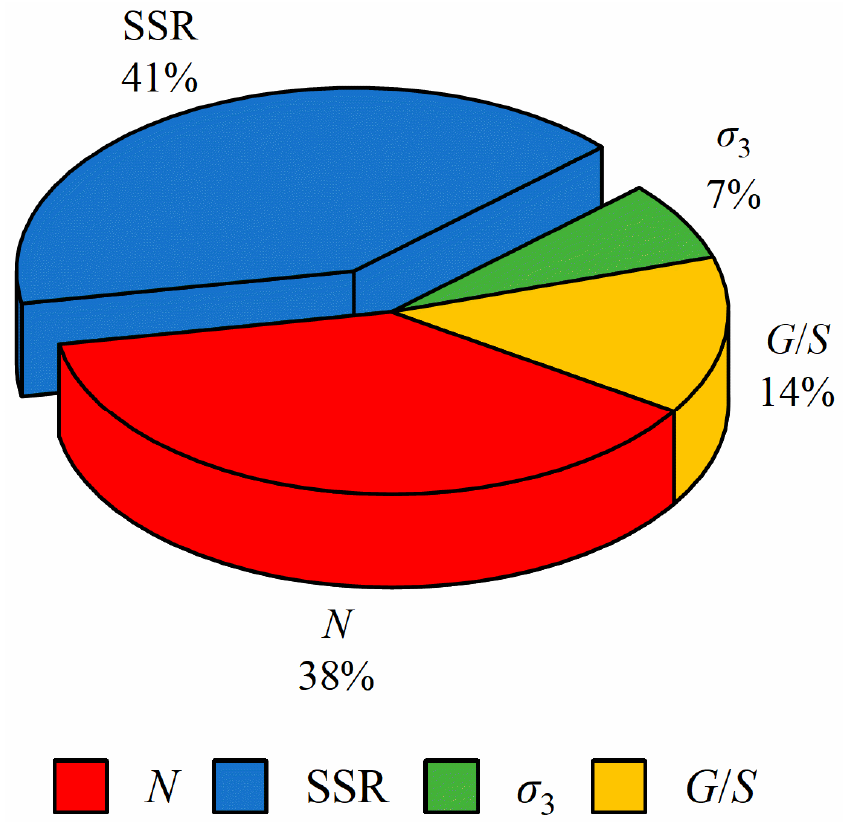
Figure 17. Influence coefficients of the selected input variables of the predicted permanent deformation.